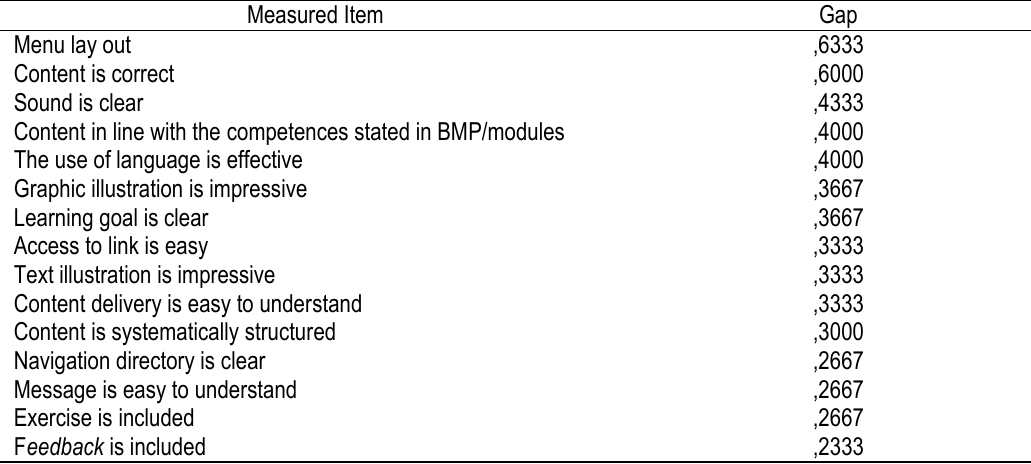
Table 2. Gap Sequence of Each item Measured Item Gap